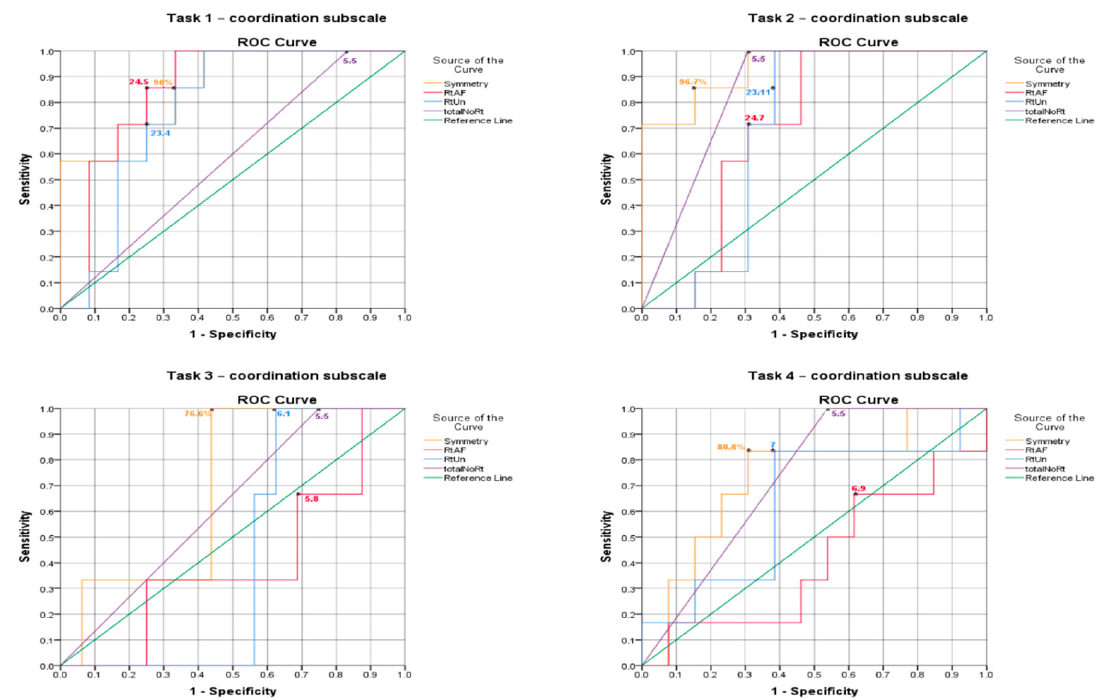
Figure 3. Receiver operator curves (ROC) of the iTIS coordination subscale parameters to distinguish between stroke participants with impairment (scored zero on cTIS-V2 tasks) and those without trunk impairment (scored one, or two on cTIS-V2 tasks). * indicates cut-off points.